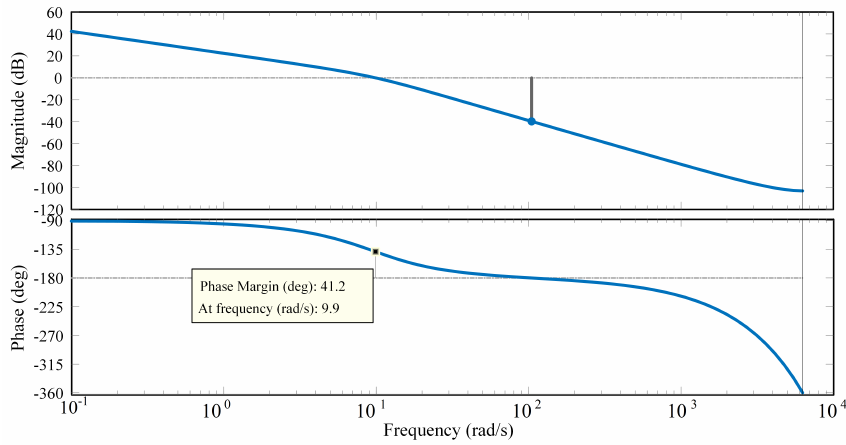
Figure 9. Bode diagram of fractional-order impedance controller.